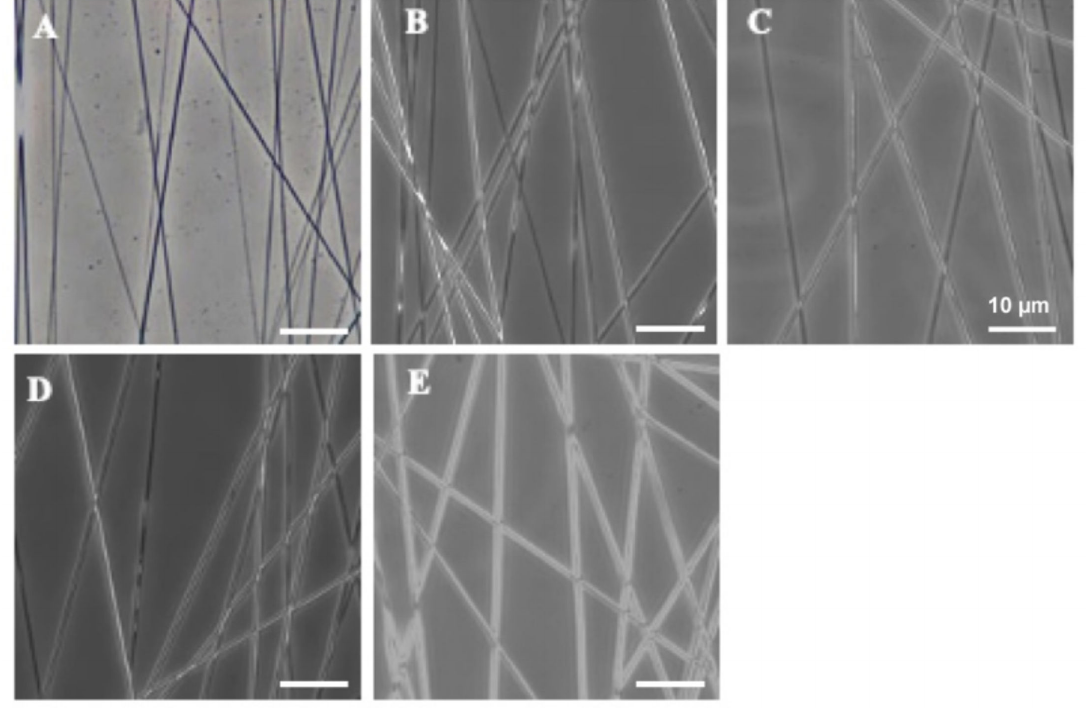
Figure 1. Phase-contrast images showing fabricated PCL/GT nanofibers at different ratio ( A ) 100:0, ( B ) 70:30, ( C ) 50:50, ( D ) 30:70, ( E )